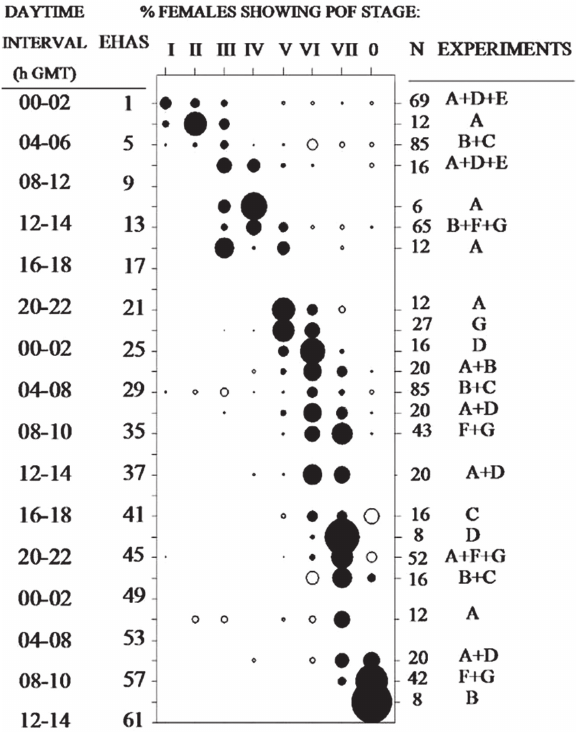
Fig . 1. – Percentages of occurrence of PoFs degeneration stages over time, for all the experiments pooled together. eHAs, estimated hours after assumed spawning during two hourly daytime intervals. n, number of females analysed. eXPeriMents, codes of the ex- periments used for the present analysis. the size of bubbles is pro- portional to the relative abundance (%) per time interval of females showing a determinate PoF stage. Black bubbles correspond to the likely progression of the degeneration of PoFs during stages, over time, for the modal spawning cohort entering the tanks. White bub- bles represent observations considered by the authors as unlikely to correspond to modal spawning cohort, i.e. “noisy” data for the present analyses; right-top observations would arise from a previ- ous spawning cohort entering the tanks whilst left-bottom observa- tions would correspond to later residual spawning taking place in the